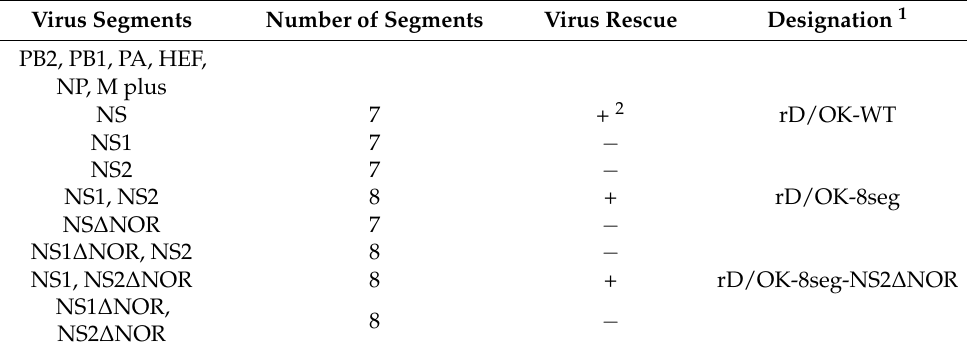
Table 1. Generation of the rD/OK-8seg and its mutant.